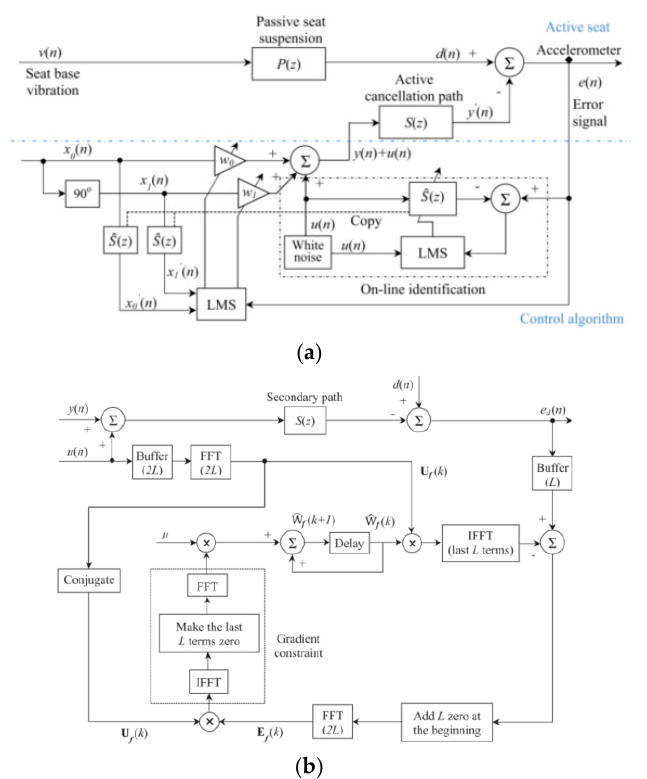
Figure 17. (a) The block diagrams of the filtered-X least mean square (FXLMS) controller (b) Fast- block least-mean-square FBLMS controller [63].